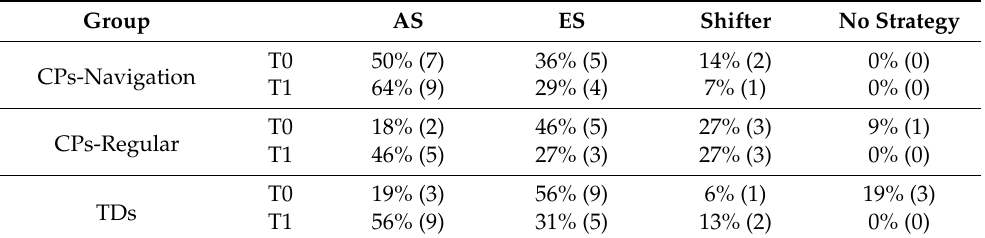
Table 4. Distribution of the strategies freely adopted by TD and CP subjects. The table reports the % and the total number of subjects between brackets.